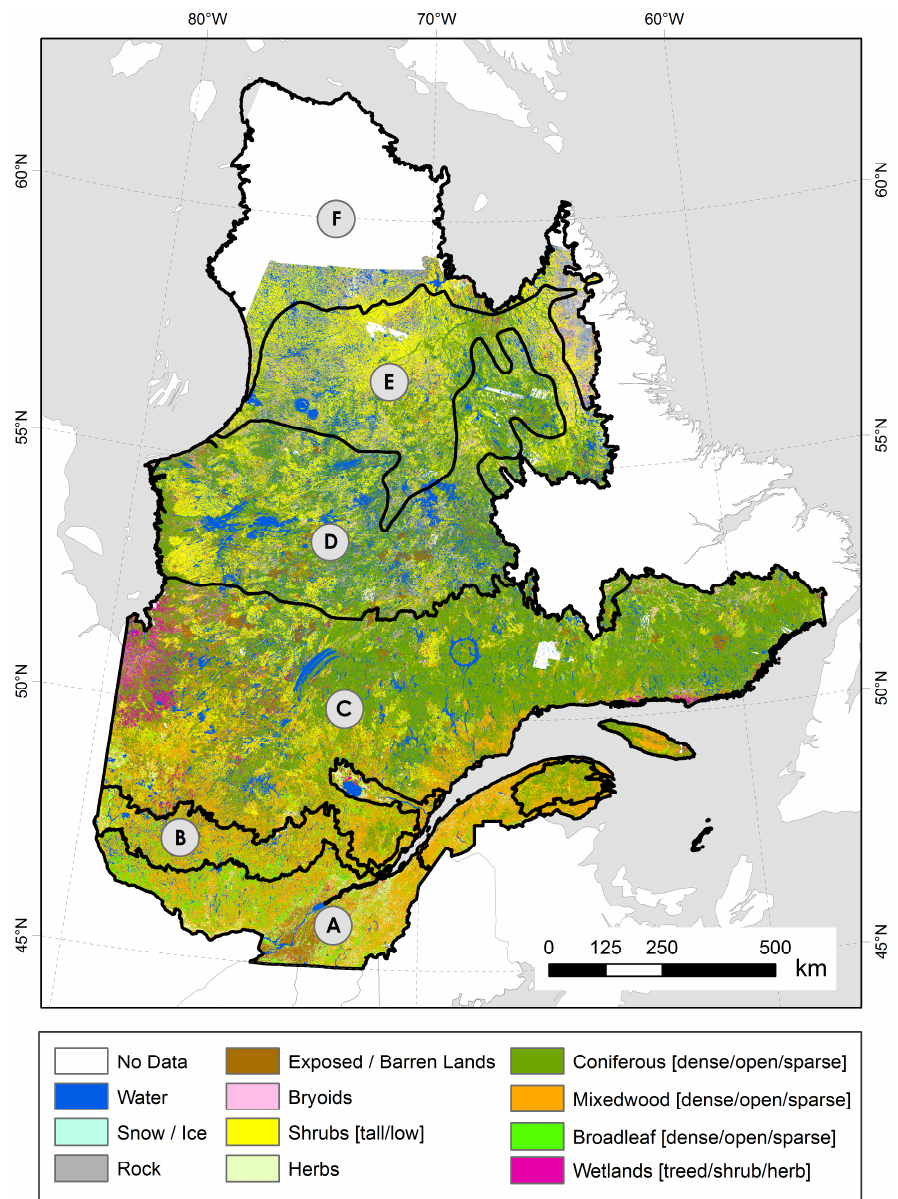
Figure 1. Earth Observation for Sustainable Development of Forests land-cover (EOSD) land cover in the province of Quebec, Canada. Ministère des Ressources naturelles du Québec (MRN) vegetation subzones (black lettering) express the broad spatial variability along the large bioclimatic gradient. Subzones are (A) hardwood forest; (B) mixed forest; (C) continuous boreal forest; (D) taiga; (E) forested tundra. Subzone F in far northern Quebec is non-forested and not part of the EOSD forest classification. Some smaller land-cover categories were combined to increase